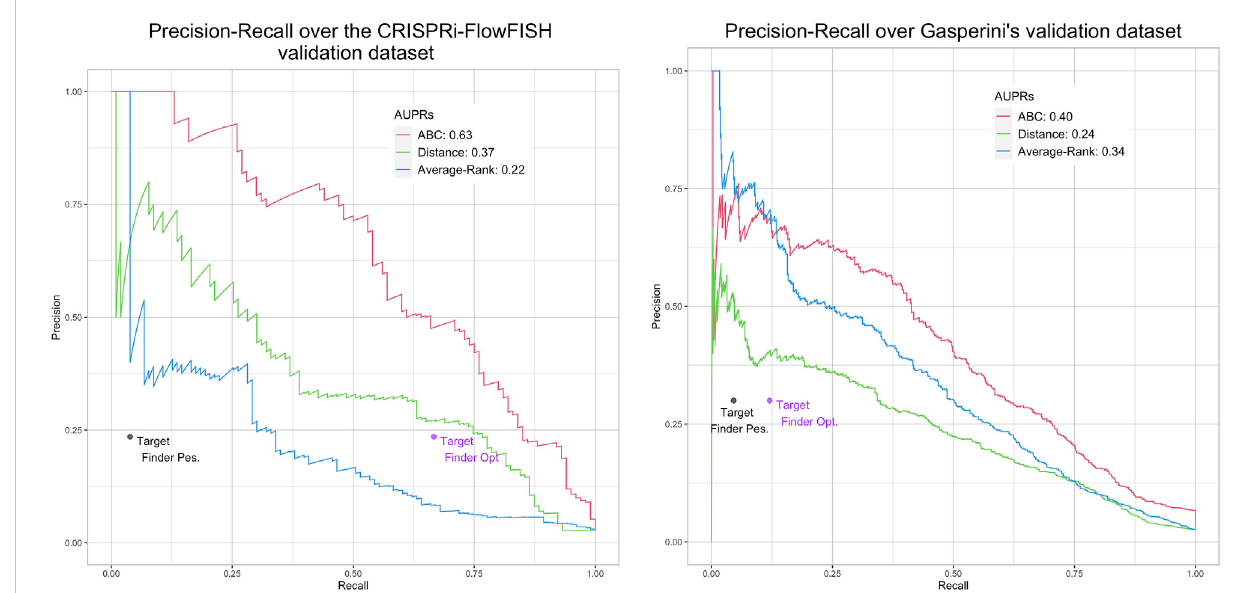
FIGURE 4 Performancesof ABCmodel , distance , Average-Rank and TargetFinder methodsontheK562 CRiFF (A) and CRISPRi (B) evaluationsets.For each method except TargetFinder , a Precision-Recall curve and an AUPR (Area Under the Precision-Recall curve) are provided. For TargetFinder , the two dots, TargetFinder_pes and TargetFinder_opt , correspond to two different ways of computing recall, a pessimistic and an optimistic one (see Material and methods and Table 2 for more details).